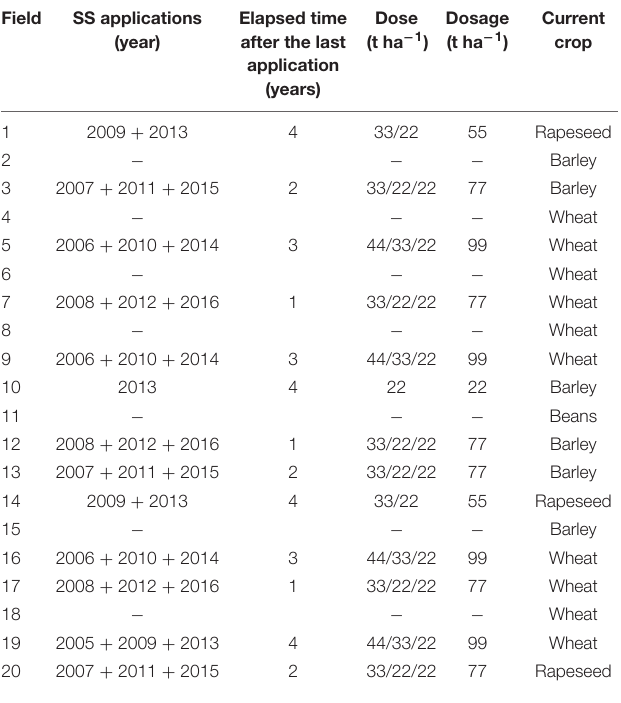
TABLE 1 | Experimental design: description of the 20 agricultural